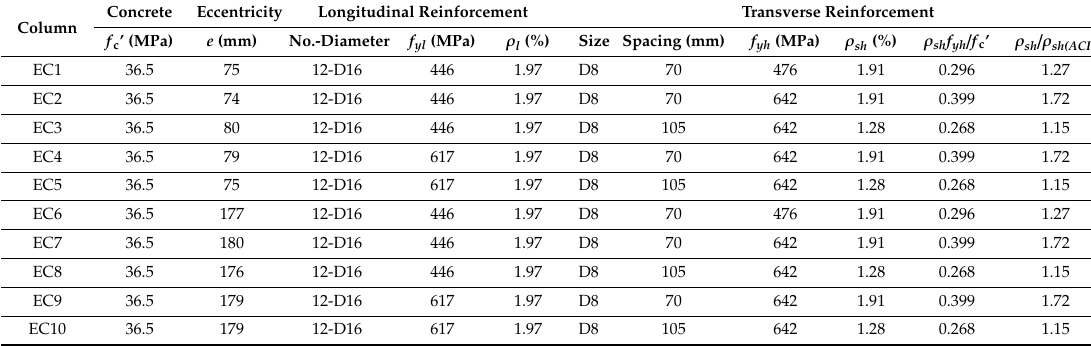
Figure 2. Geometric sizes and reinforcement details. Table 1. Test design